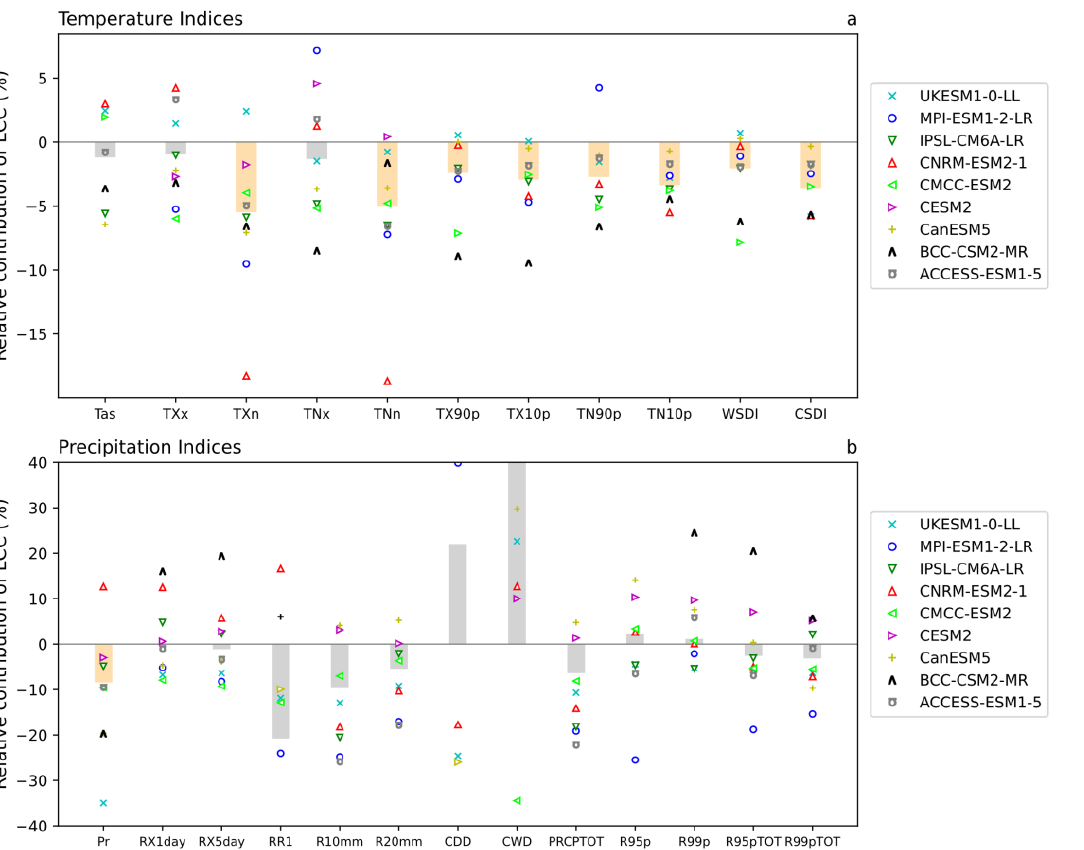
Figure 4. Under SSP1-2.6 scenario, the multi-model ensemble global-averaged relative contribution of land use change (i.e., ssp126-ssp370lu − ssp126) to temperature extremes ( a ) and precipitation extremes ( b ); relative contributions are calculated relative to future global projections with all other anthropogenic forcings (see Methods). Extreme climate indices are averaged over 2070–2099. Light yellow bars correspond to at least 80% of models simulating the same global change sign.